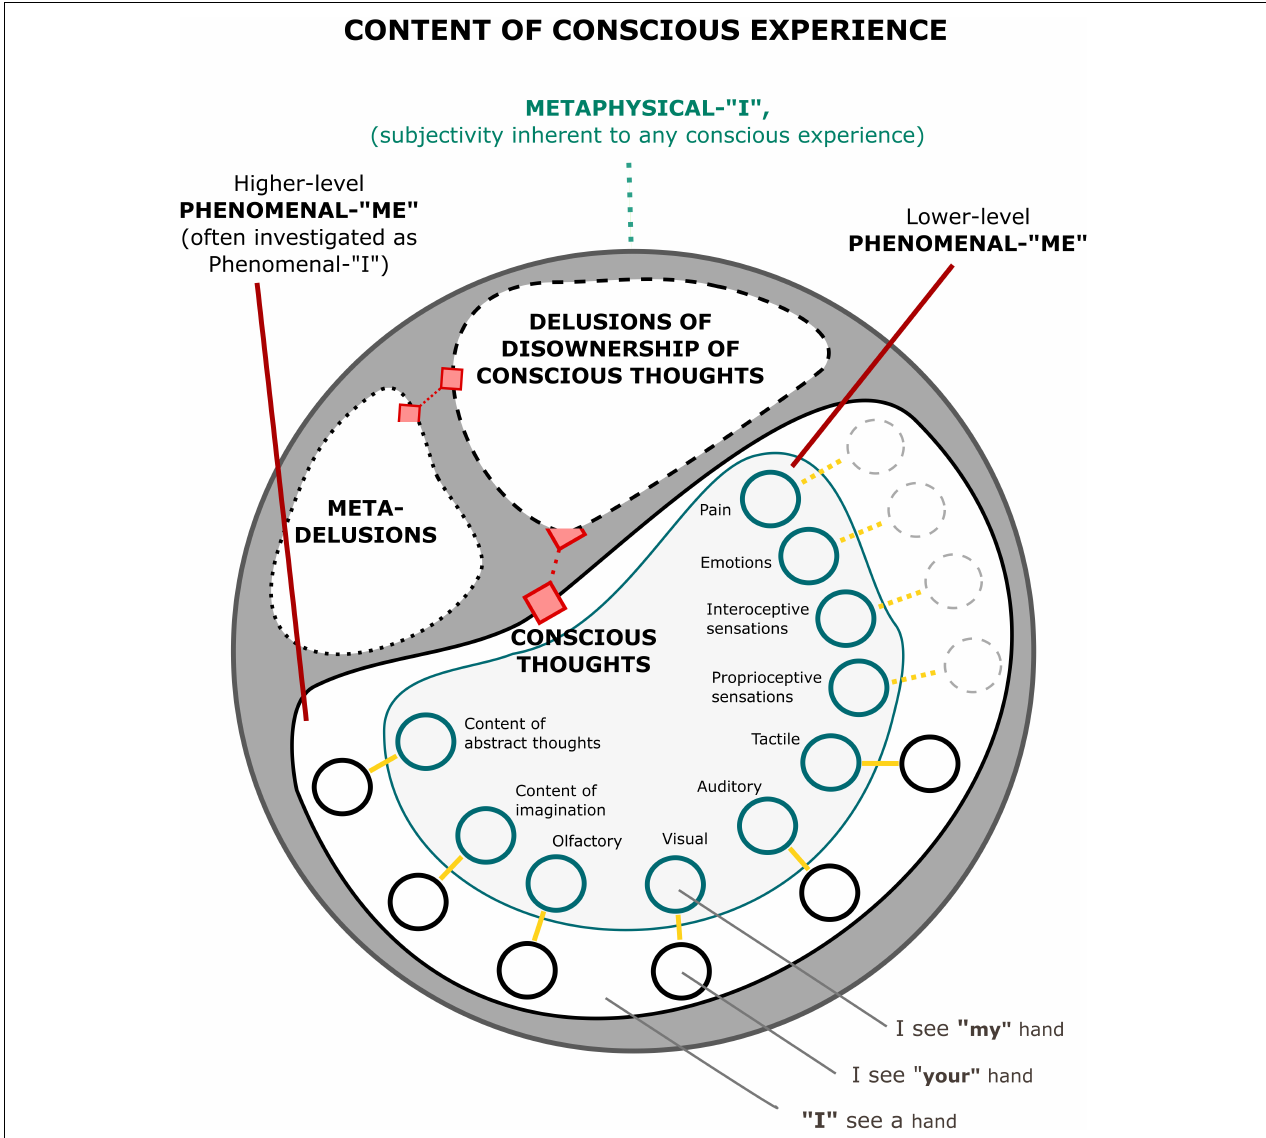
FIGURE 2 | A simplified representation of a structure of phenomenal content including the metaphysical “I,” the phenomenal “Me,” and the phenomenal “I,” which can be understood (see in text) as a higher-level element of the phenomenal “Me.” Each pair of nodes connected with a yellow line represents one type of content of consciousness, with indigo nodes corresponding to self-related content, and black nodes corresponding to non-self-related content. In some cases (e.g., pain, emotions, interoceptive, and proprioceptive sensations), the black nodes are lighter and drawn with a dashed line (the same applies to links), to indicate that in normal circumstances one does not experiences these sensations as representing another person (although it is possible in thought experiments and pathologies). Multisensory/multimodal interactions have been omitted for the sake of clarity. All of the nodes compose the set of conscious thoughts, which can be formulated as “I experience X.” In normal circumstances, one does not deny ownership over these thoughts, however, in thought experiments, and in some cases of psychosis, one may experience that even such thoughts cease to feel as one’s own. This situation is represented by the shape with a dashed outline. Moreover, in special